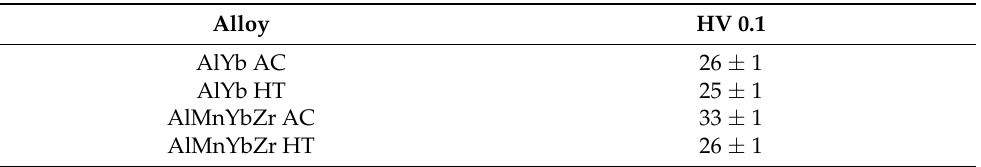
Table 2. Initial values of microhardness HV0.1 for the AlYb and AlMnYbZr alloys in the as-cast state (AC) and after high temperature ageing at 625 °C for 24 h (HT).